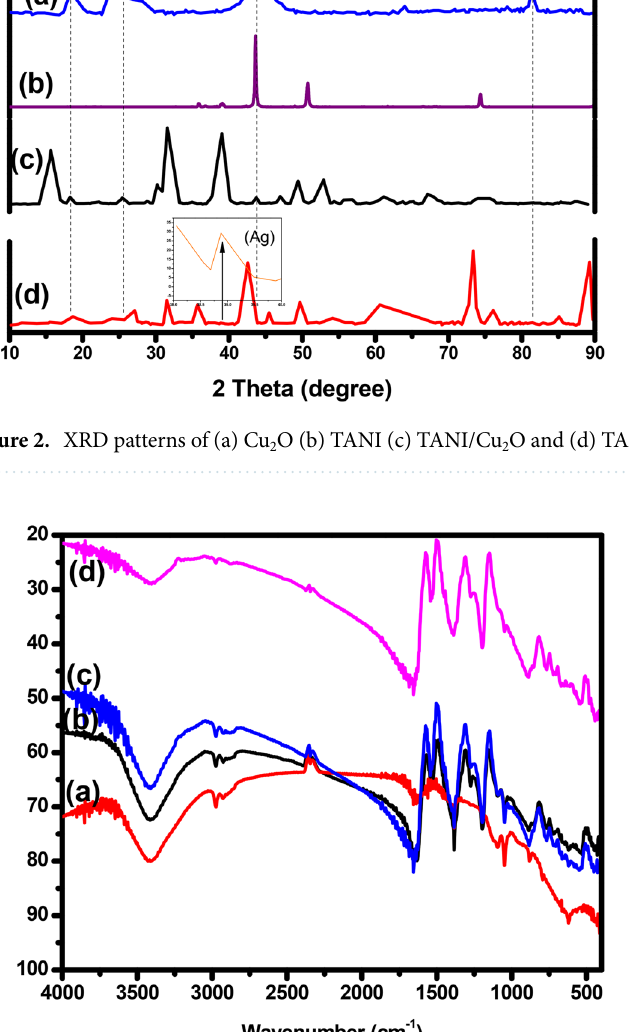
pattern of Cu 2 O NPs has sharp peak at 2θ = 44° which corresponds to the (111) planes (standard JCPDS file No. 05-661) along with certain other peaks of low intensity 30 . However, these peaks show slightly shifted from their respective standard positions which may be due to the presence of Cu 2 O and Ag into TANI matrix. These results are further compiled with FTIR. FTIR analysis. The FTIR spectra of synthesized Cu 2 O, TANI, TANI/Cu 2 O and TCA NCs are depicted in Fig. 3. The broad absorption peak in the range of 750–550 cm −1 can be attributed to C–NO 3− bonding is observed